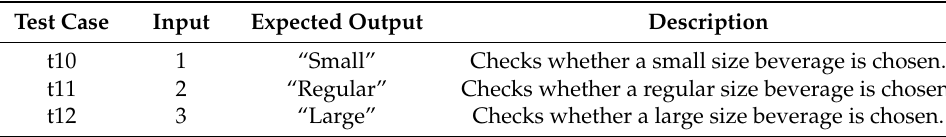
Figure 4. The feature model for SPL V1 . Table 6. New test cases for SPL V1 .